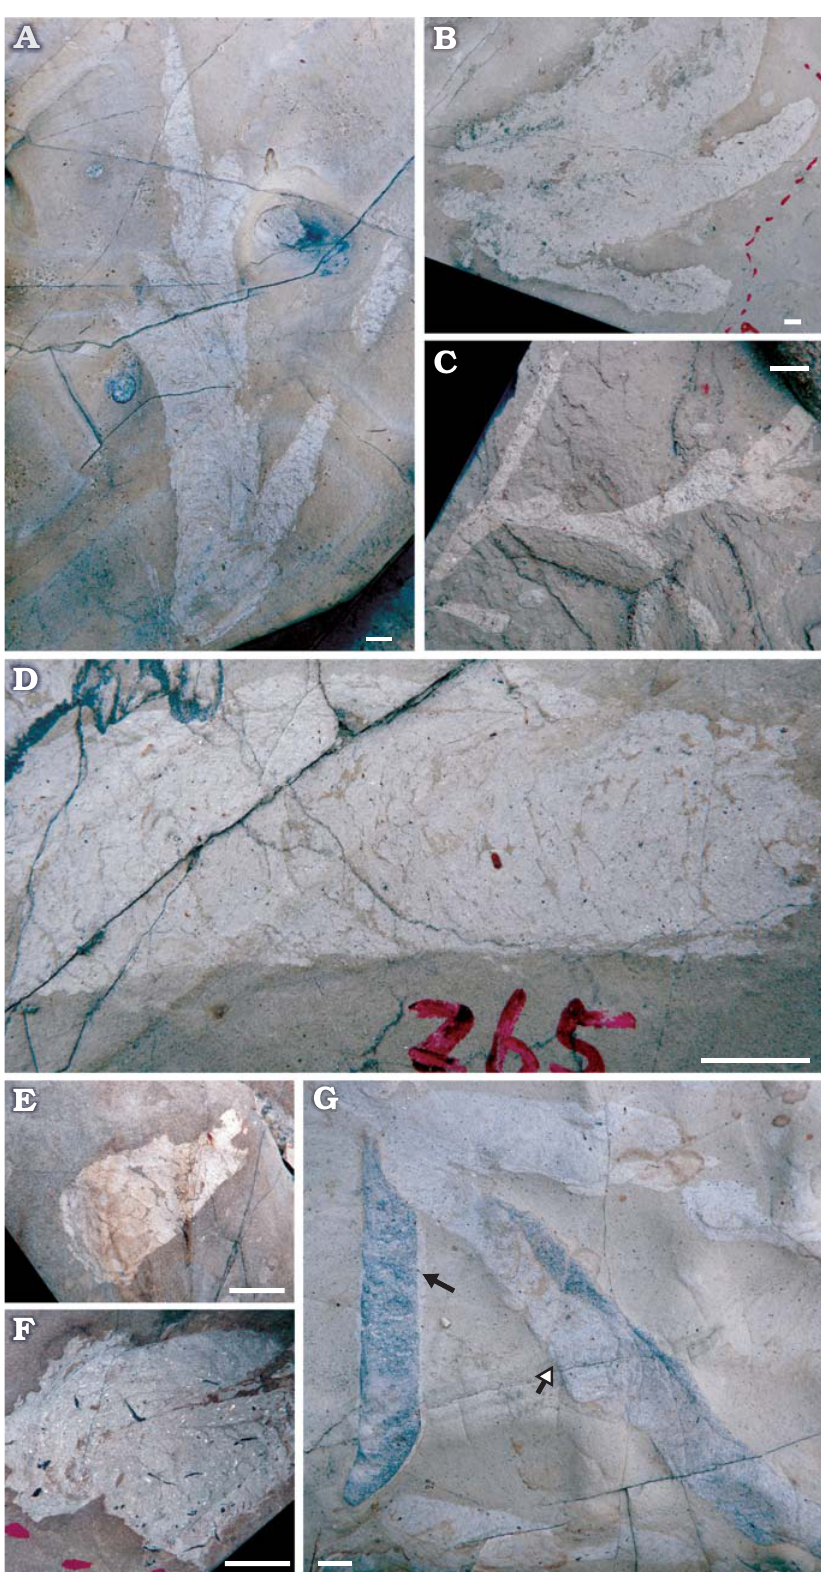
Fig. 2. Phymatoderma burrows from the Shiramazu Formation, Shioura (A–D) and Hiraiso (E–G) sec- tions, Chiba Prefecture, central Japan. A–C . General views. Branched overlaping tunnels ( A ). Entire spec- imen representing a digitate morphology ( B ). Tunnels showing second-ordered branching ( C ). D . Magnified view of the burrow, focusing on the presence of the pelletal infill. E , F . Pellets with various kinds of com- positions. White-colored volcanic-ash pellets ( E ) and light gray-colored muddy pellets ( F ). G . Specimen with revisiting structures. Note that white-colored tunnel first (black arrow), black-colored tunnel with scoriaceous infill second, and then white-colored tun- nel (white arrow) came again. Field photos; all except E parallel (or nearly parallel) views to the bedding plane; E, obliquely cut vertical cross-sectional view. Scale bars 10